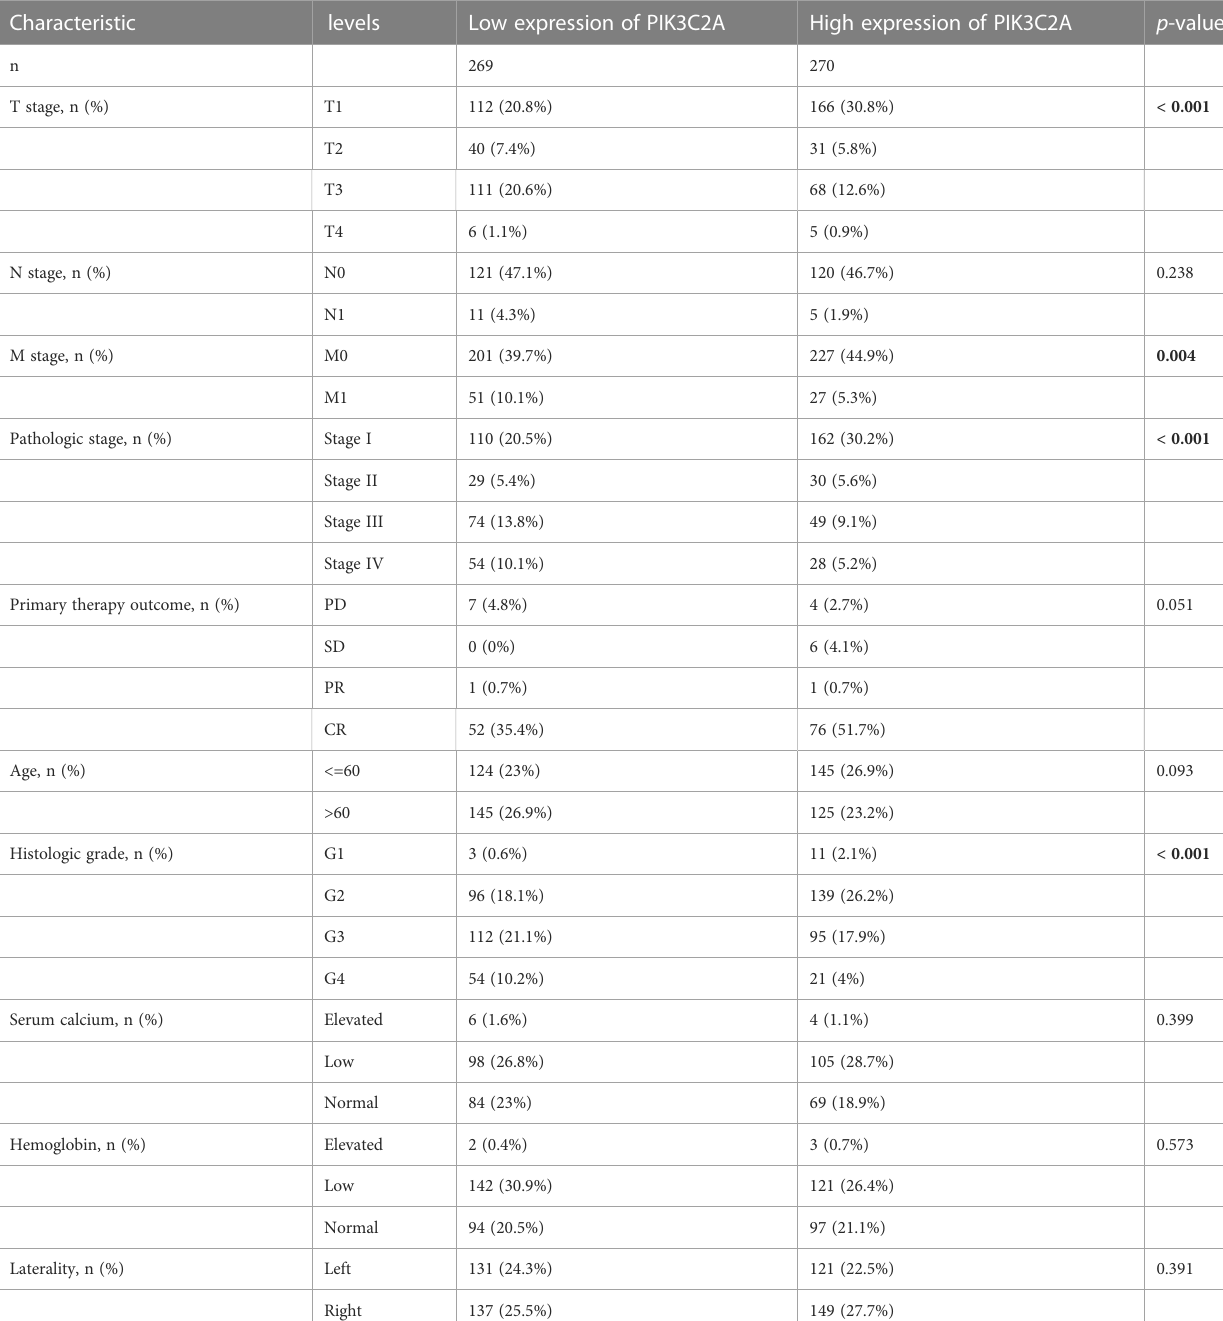
TABLE 1 Correlations of PIK3C2A expression with the clinicopathological features of KIRC. Characteristic